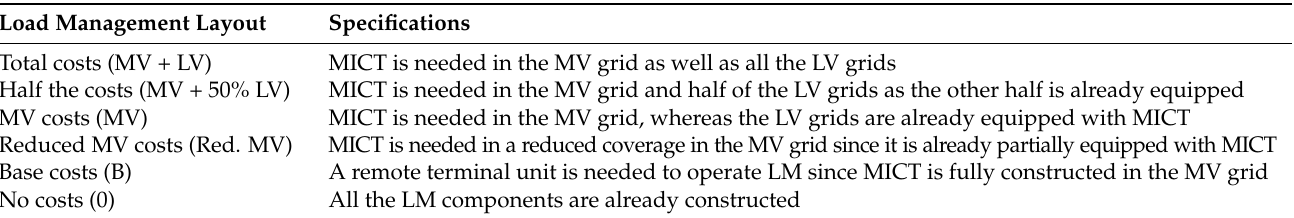
Table 4. Specification of the six load management layouts based on